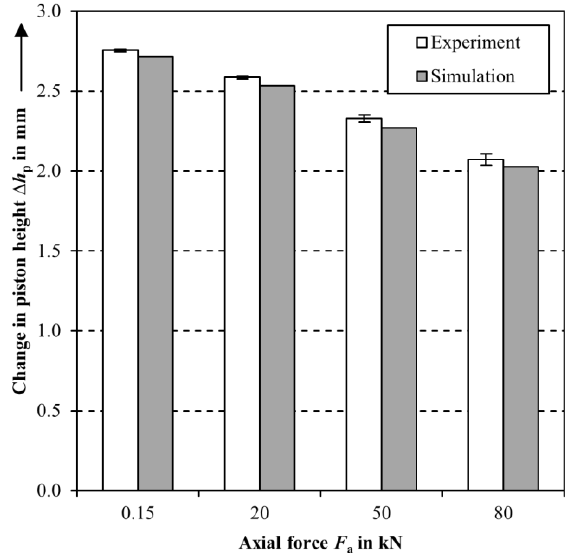
Figure 5. Comparing change in piston height ∆ h p of experimental and simulated data for different axial forces F a.